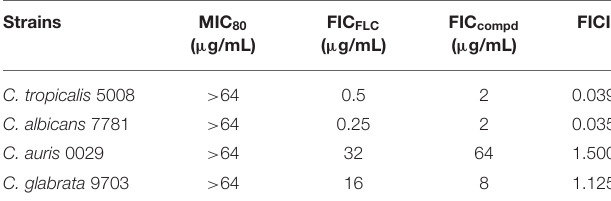
FIC FLC FIC compd FICI ( µ g/mL) ( µ g/mL) ( µ g/mL)